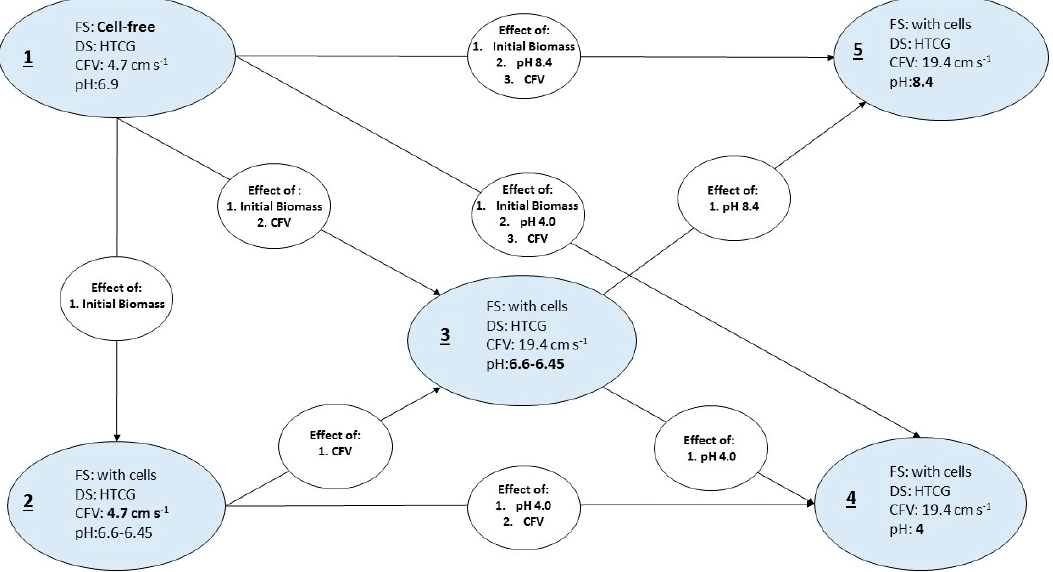
Figure 2. Graphical representation of the experimental setup and the possible interaction. FS: feed solution, DS: Draw solution, CFV: cross-flow velocity, HTCG: hexane-treated crude glycerol. Five setups were used with a one-variable-at-time experimental approach. The possible effects that can be studied are presented in the white oval shapes.